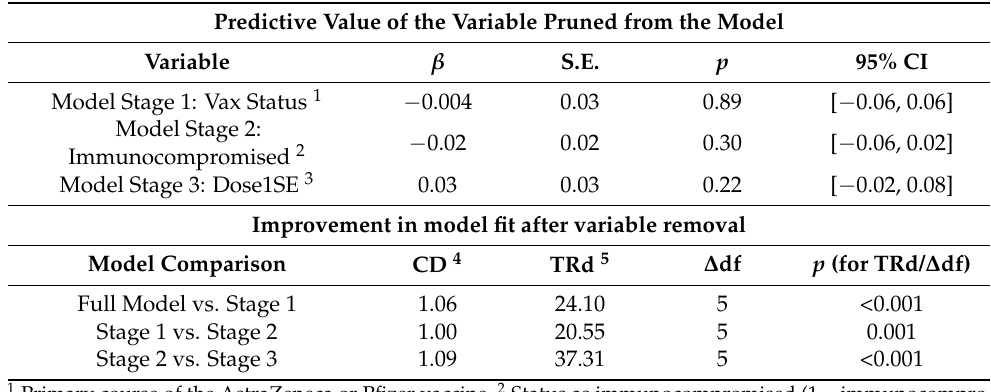
Table 4. Predictors pruned from the model at each stage of model refinement (Australian sample). Predictive Value of the Variable Pruned from the Model